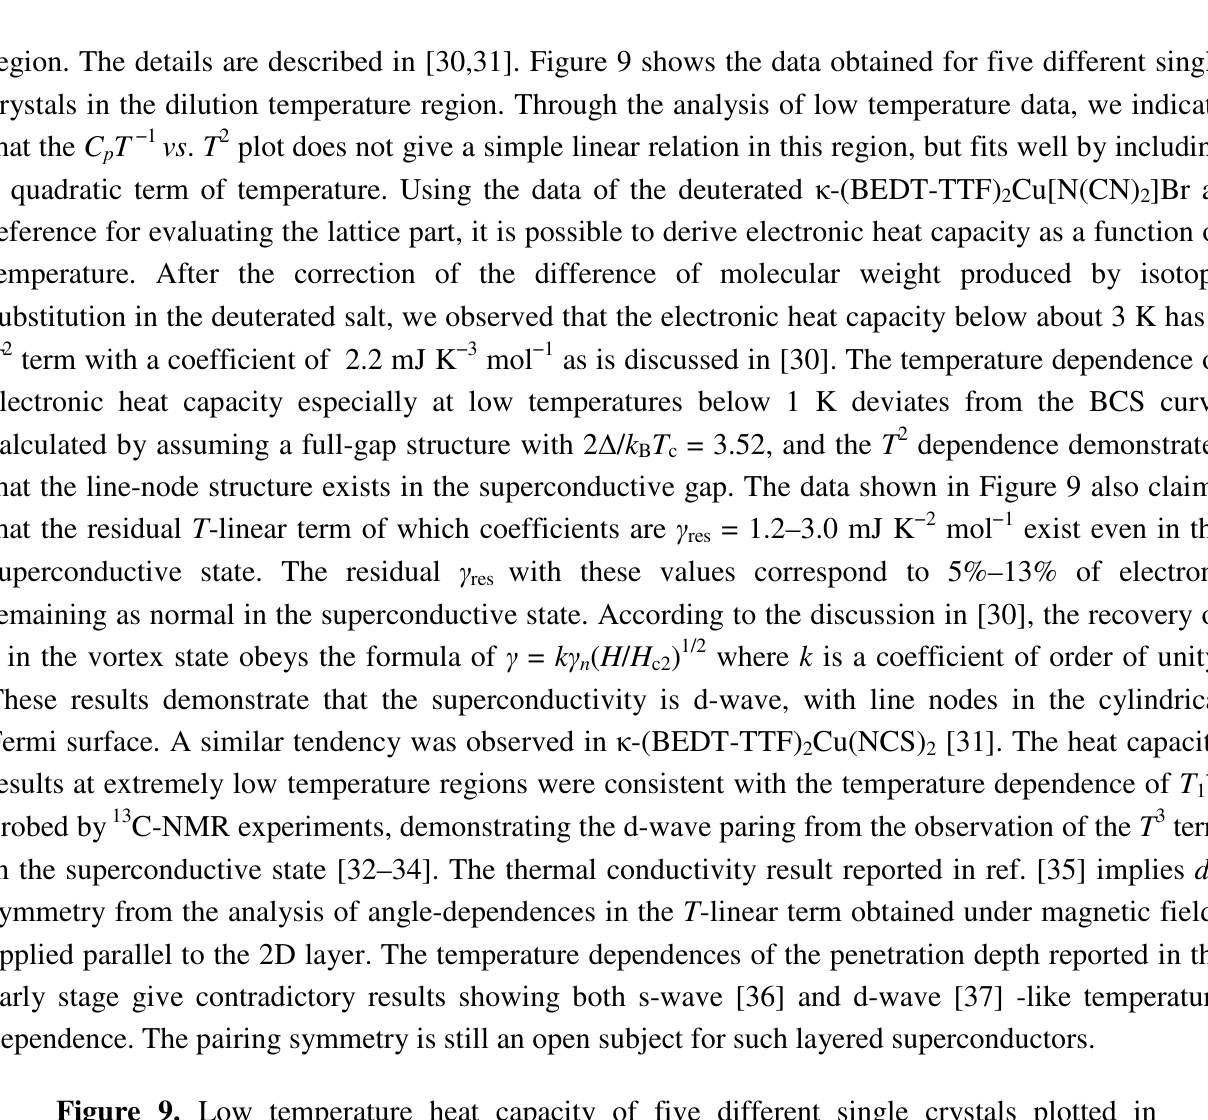
Figure 9. Low temperature heat capacity of five different single crystals plotted in T −1 vs . T 2 . The data show a deviation from linearity due to the existence of the T 2 term C p and the residual T -linear in C term remains even in the superconductive p